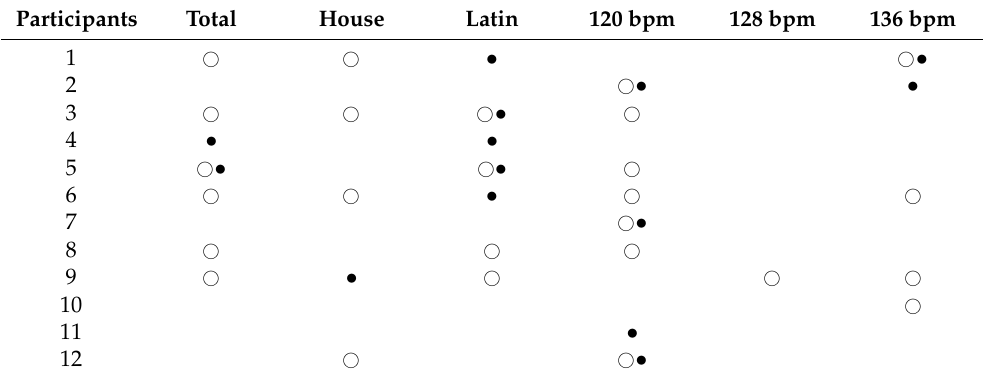
Table 5. Presence of music-breathing entrainment when considering one-quarter of music tempo as the music beat